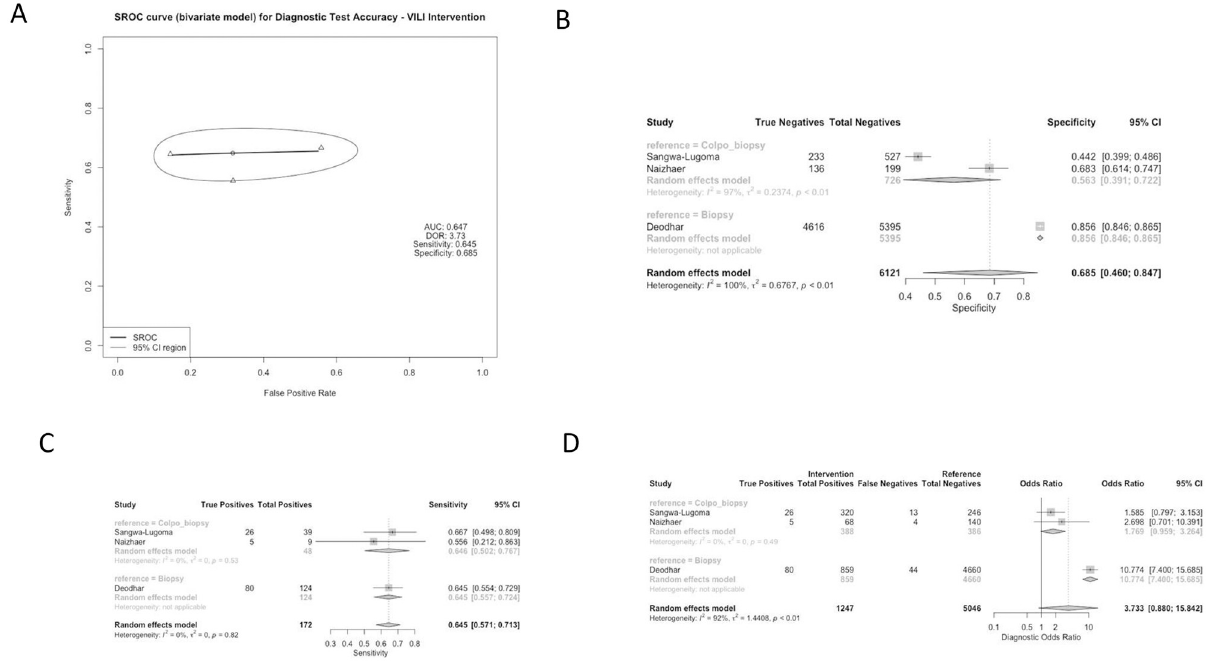
Fig 3. Panel A: Pooled Receiver Operating Characteristic for Diagnostic Test Accuracy for VILI intervention. Panel B: Specificity of Studies for VILI intervention. Panel C: Sensitivity of Studies for VILI intervention. Panel D: Diagnostic Odds Ratio for VILI intervention.